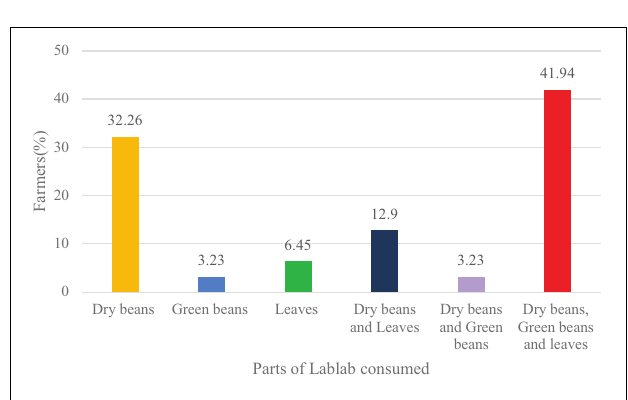
FIGURE 1 | Utilization of lablab by respondents.